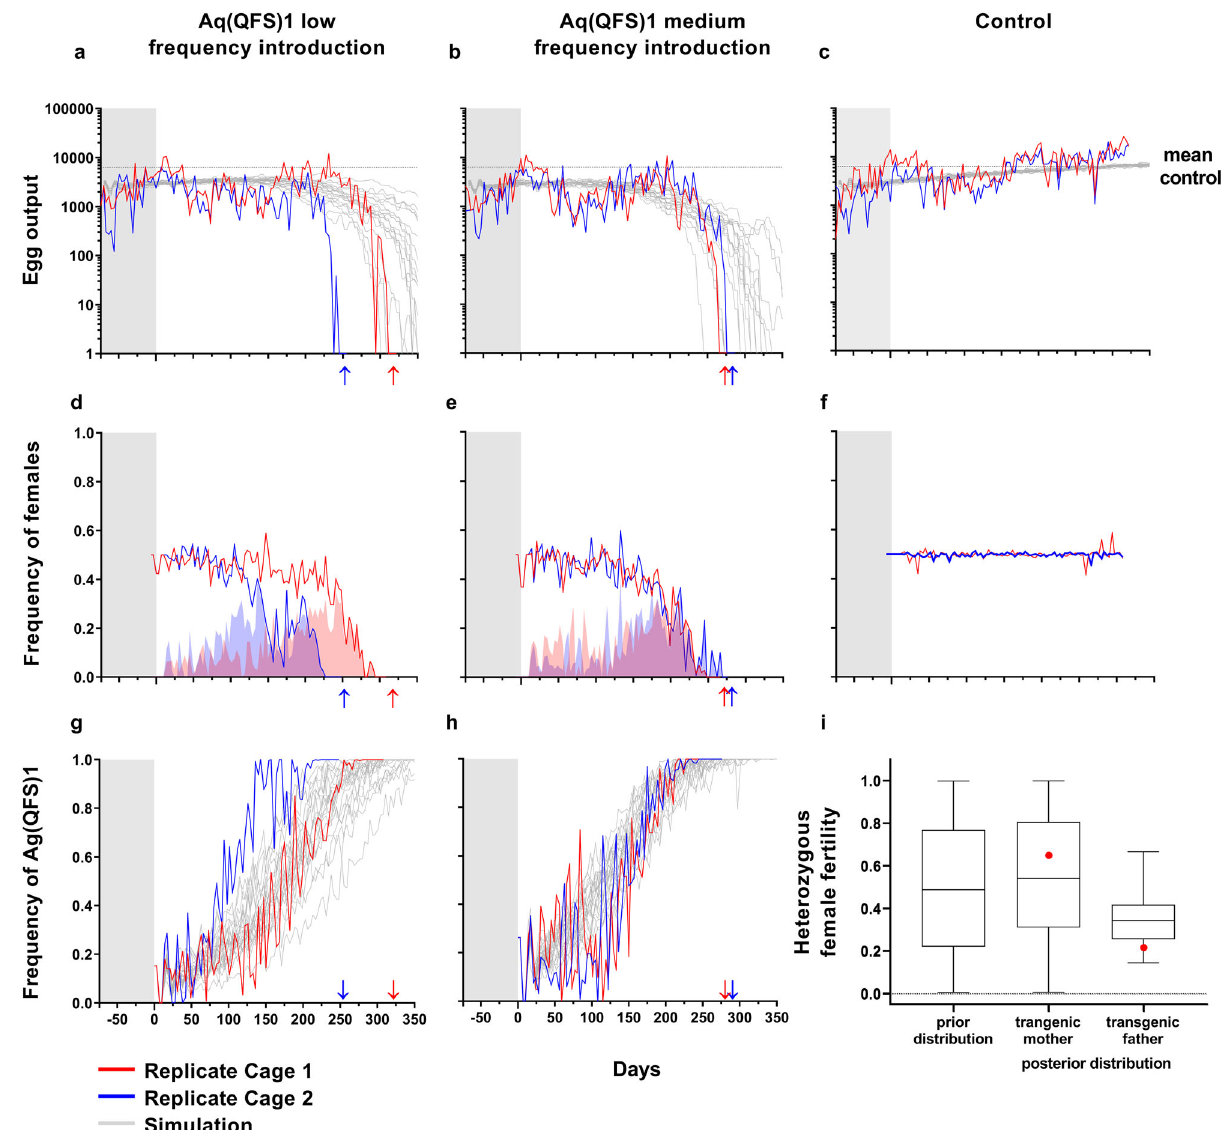
Fig. 2 Kinetics of spread of Ag(QFS)1 in age-structured large cage populations. We clari fi ed the legend as following: Age-structured large cage (ASL) populations were established over a period of 74 days (shaded grey) and seeded in duplicate with Ag(QFS)1 heterozygous males at low (12.5%, a , d , g ) and medium (25%, b , e , h ) allelic frequency, whereas two control ASL populations were maintained without introduction of the Ag(QFS)1 gene drive ( c , f ). The total egg output ( a , b , c ), the total frequency of females with apparently normal external morphology (i.e. wild type and heterozygous) ( d , e , f ), and the frequency of Ag(QFS)1 alleles ( g , h ) were monitored over time (red and blue lines for replicate cages). Mean egg output of the control is indicated by a dashed line ( a , b , c ). Red and blue shaded areas indicate the fraction of morphological females that carried the gene drive in heterozygosity (red), or were wild type (blue) ( d , e ). Arrows indicate the point at which no further eggs were recovered, the point at which populations were considered eliminated. A total of 20 stochastic simulations of the egg output and the frequency of Ag(QFS)1 (grey lines) were modelled using default parameters based on Kyrou et al. 9 and expert judgement (Supp. Methods), superimposed to experimental data for the control and gene drive introductions ( a , b , c , g , h ). n = 200 samples from the prior and posterior distribution of the relative fertility of Ag(QFS)1 heterozygous females that putatively received deposited nuclease paternally or maternally, as compared to the average fertility of wild-type females ( i ). Fertility distributions are represented as boxplots where the centre line denotes the median relative fertility (50th percentile), lower and upper bounds of the box contain the fi rst and third quartiles, and whiskers mark the minimum and maximum values. Shown in red are the estimates of female fertility from experimental observation in Kyrou et al. 9 . Source: Dataset